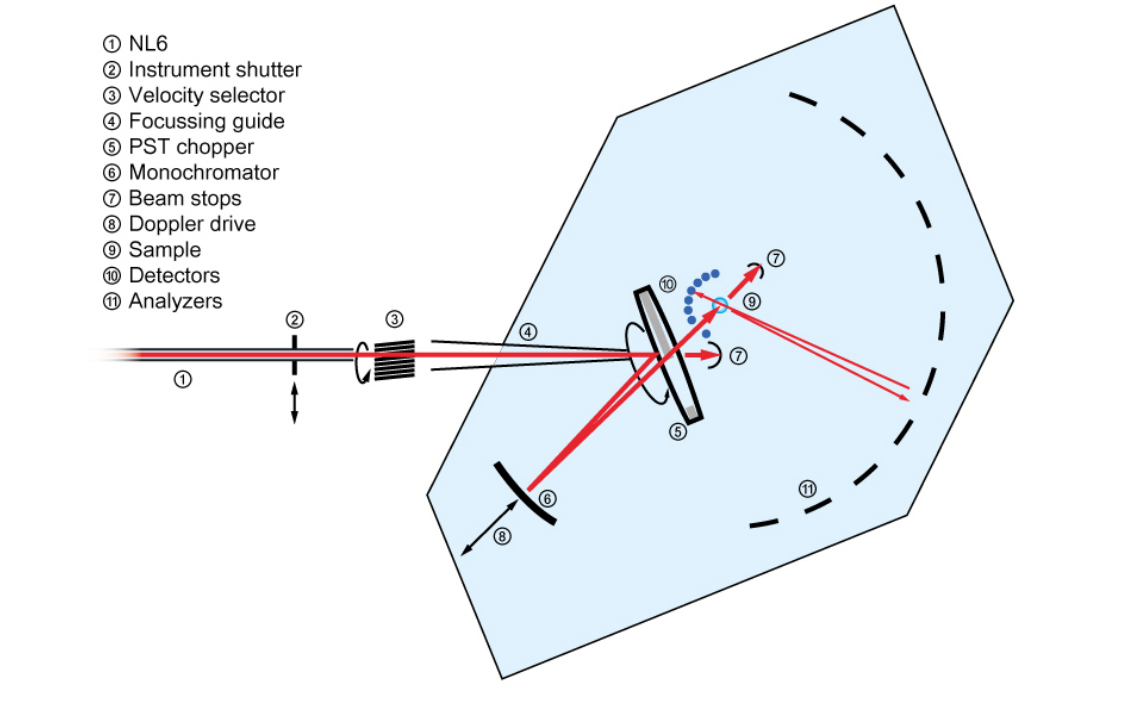
Figure 2: Schematic drawing of